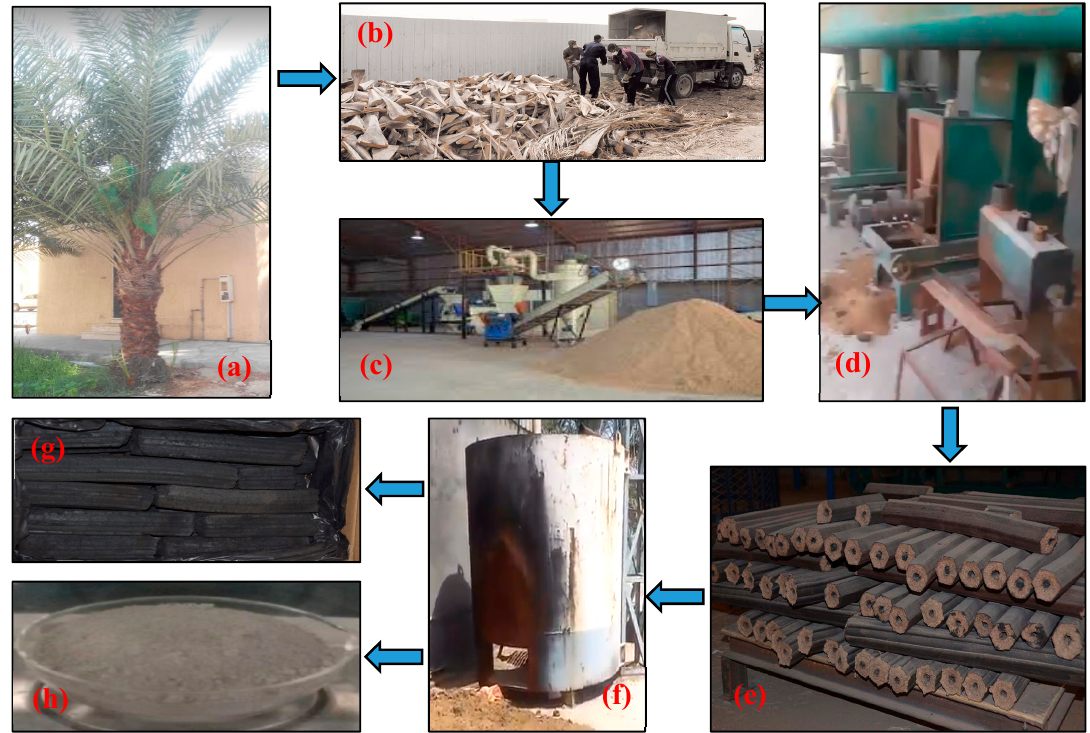
Figure 1. Stages of recycling: ( a ) typical date palm tree, ( b ) raw waste, ( c ) grinding, ( d ) compressing and molding machine, ( e ) firewood formation, ( f ) oven, ( g ) charcoal formation, and ( h ) DPA generation.